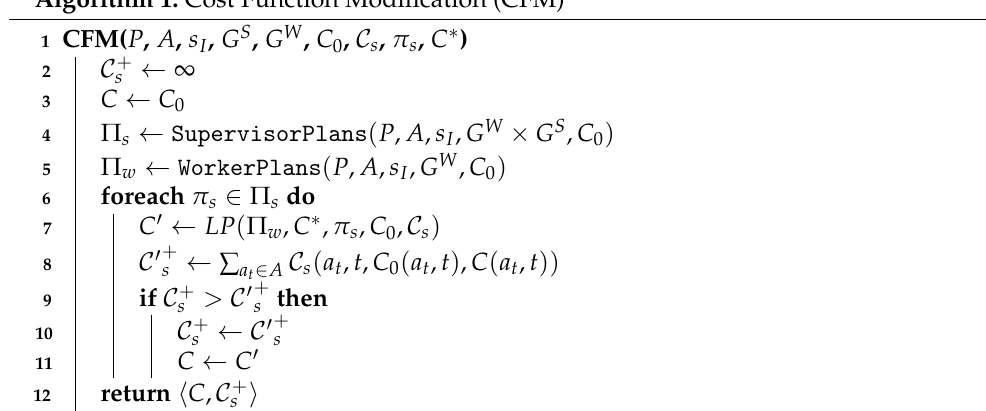
Algorithm 1: Cost Function Modification